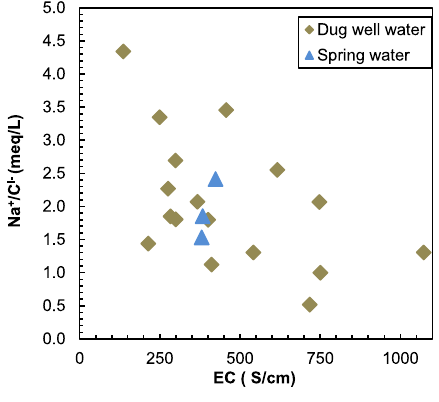
Fig. 7 Na + /Cl − versus EC of the water samples in the study area